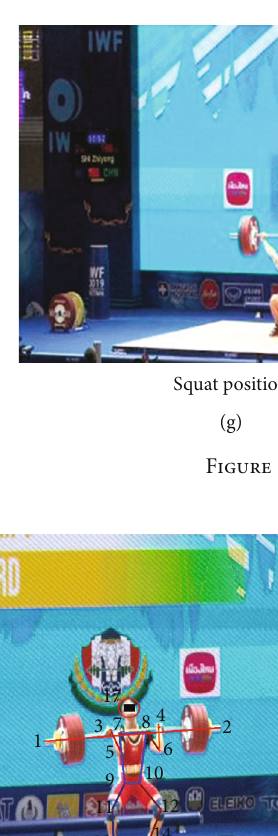
(4) Calculation of X -Axis Coordinates of Human and Bar Combination Barycenter ( X ) . The COG of human body c position on the X - axis is X 1 , the COG of barbell position on the X - axis is X 2 , the weight of lifter is M 1 , and the weight of barbell is M 2 .